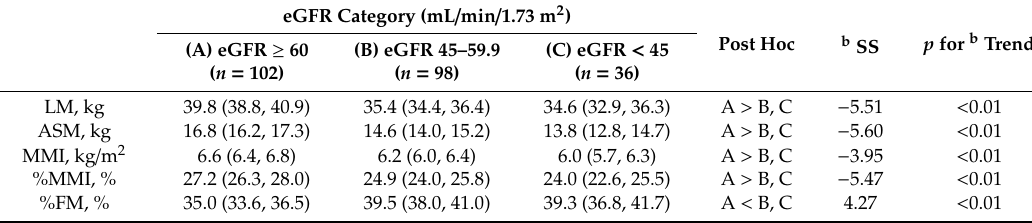
Table 3. Body composition parameters, adjusted for age and sex, and trends by eGFR